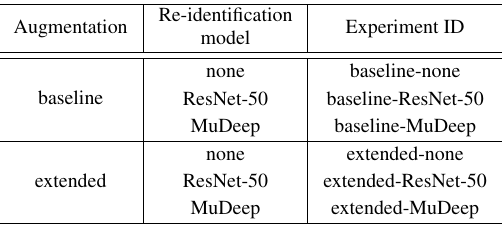
Table 2. Overview of the experiments carried out (for details see text).